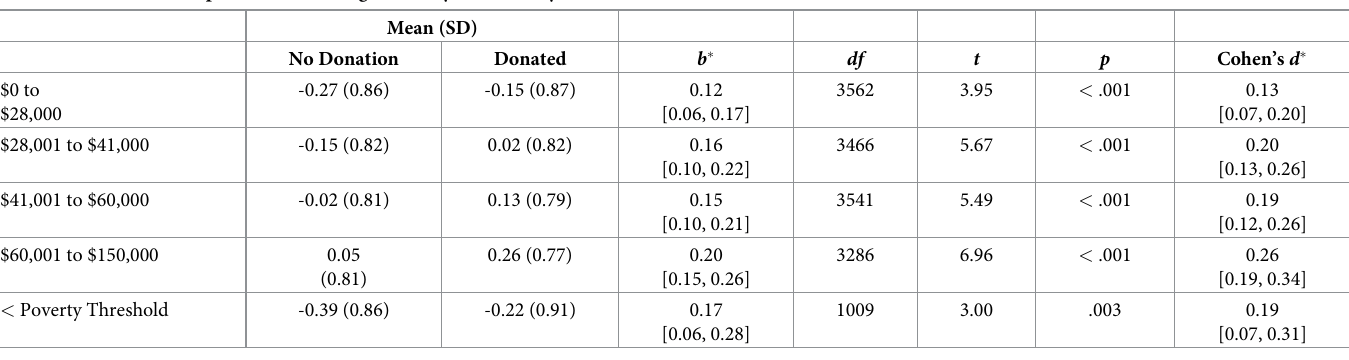
Table 3. The Relationship between donating to charity and SWB by income.